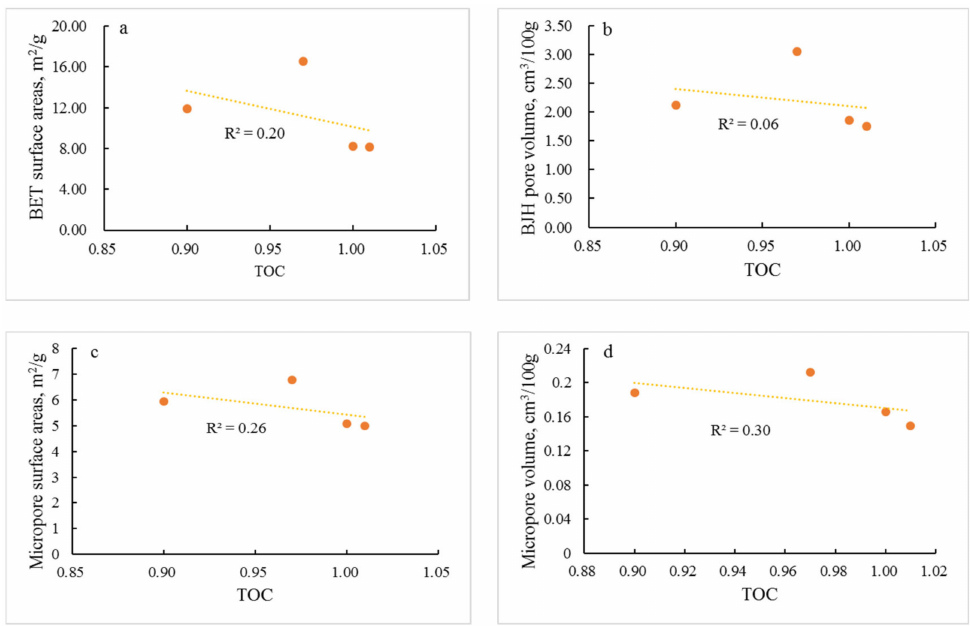
Figure 12. Mesopore surface areas and volume versus TOC content ( a , b ); micropore surface areas and volume versus TOC content ( c , d ) for argillaceous